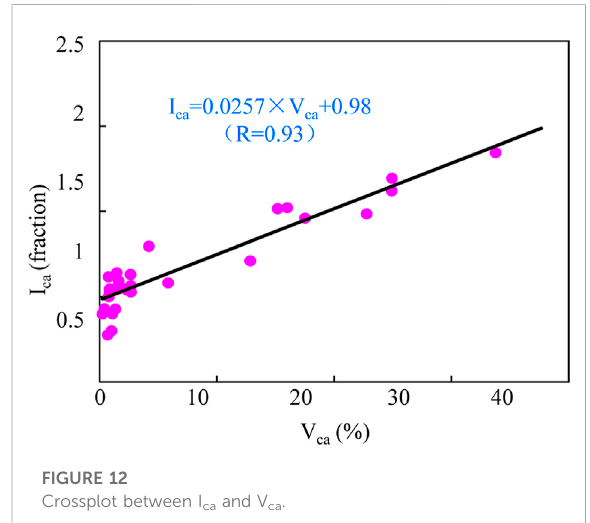
FIGURE 12 Crossplot between I ca and V ca .